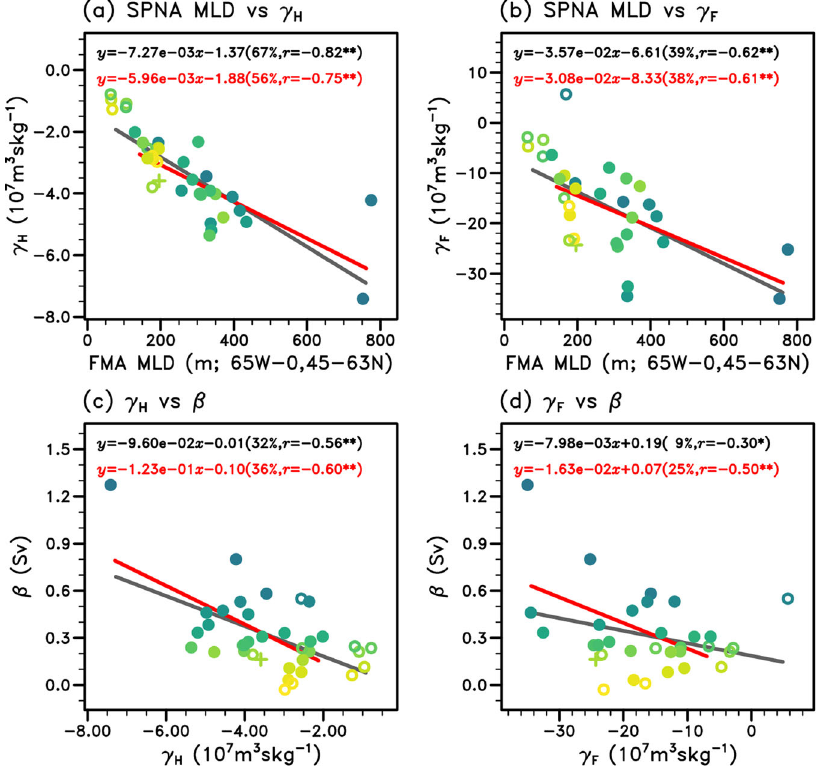
Fig. 3 Effect of mean strati fi cation on γ and β . a , b Scatterplots of FMA climatological mean SPNA MLD (unit: m) and γ (a measure of the sensitivity of the deep water formation rate to each surface fl ux) with color code for individual models following that of Fig. 1a; ( a ) for buoyancy fl ux by heat ( γ H ; unit: kg m − 2 s − 1 ), and ( b ) for buoyancy fl ux by freshwater ( γ F ; unit: kg m − 2 s − 1 ). ( c ) and ( d ) show γ H and γ F against β . Without an outlier (GISS-E2-1-G) in ( c ), the correlation is − 0.35, which is signi fi cant at the 95% con fi dence level. The notation of lines